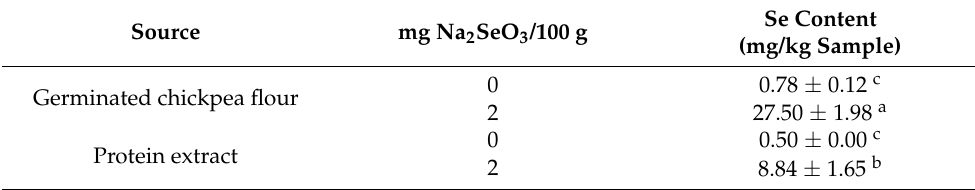
Table 1. Total selenium (Se) content in germinated chickpea flour and protein